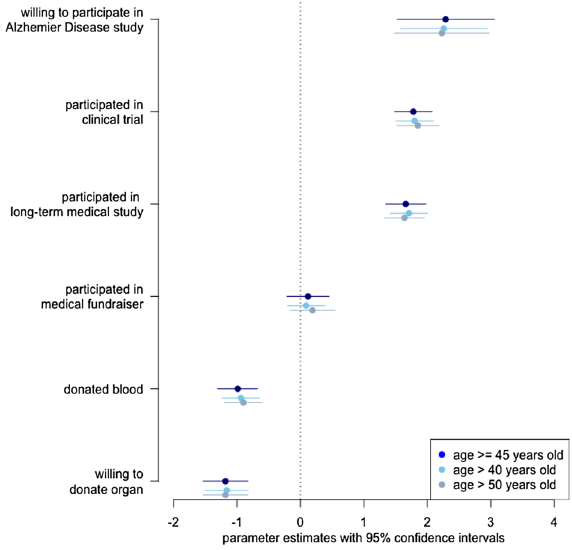
Figure 1. Difficultly parameters from IRT model of participation in medical